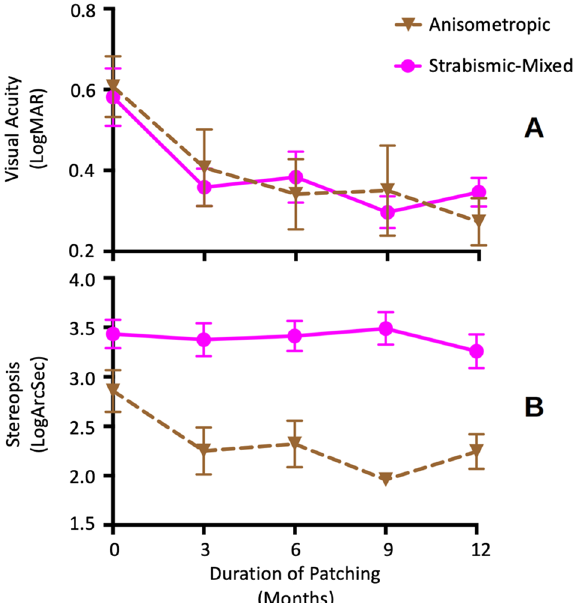
Figure 2. Visual acuity and stereoacuity per type of amblyopia. The mean and standard error of mean of visual acuity ( A ) and stereoacuity ( B ) change sub-grouped by the type of amblyopia at baseline and during the first year after initiating patching treatment. The lower scores indicate better visual acuity (log MAR) and stereoacuity (log arc sec). visual acuity and stereoacuity improvement was greater in anisometropic than strabismic/mixed group. Brown triangles—dashed line: anisometropic; magenta circles—full line: strabismic/ mixed.